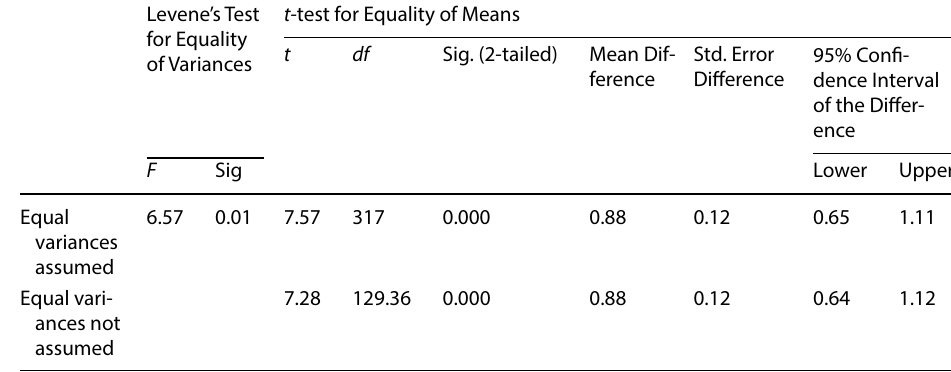
Levene’s Test The t test for Equality of for Equality of Variances